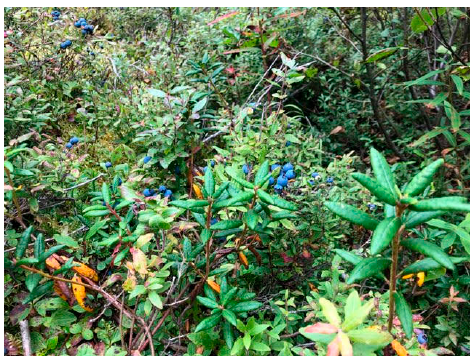
Figure 2. Naturally occurring complimentary crops (low bush blueberry, Labrador tea & moss).